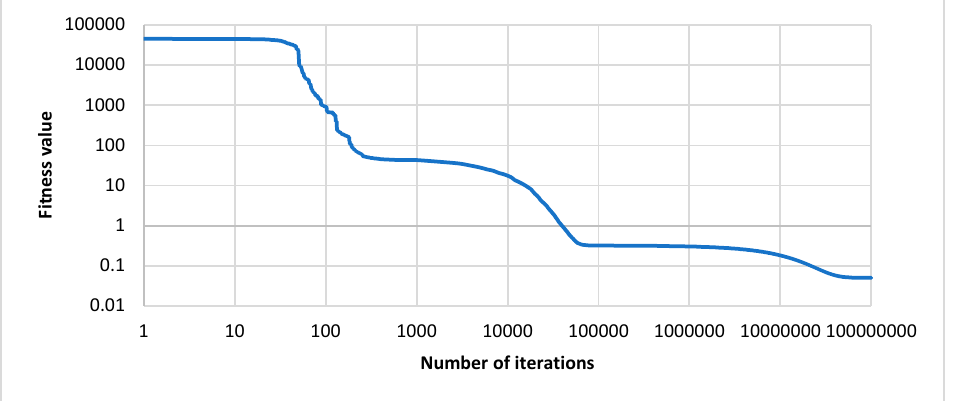
Figure 10. Dependence of the mean squared error in the process of matching a surface to a point cloud on the number of iterations on a logarithmic scale.